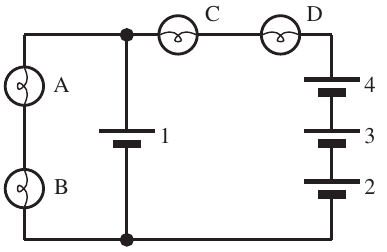
FIG. 10. Circuit diagram used in a multiple batteries in mul- tiple loops post-test.